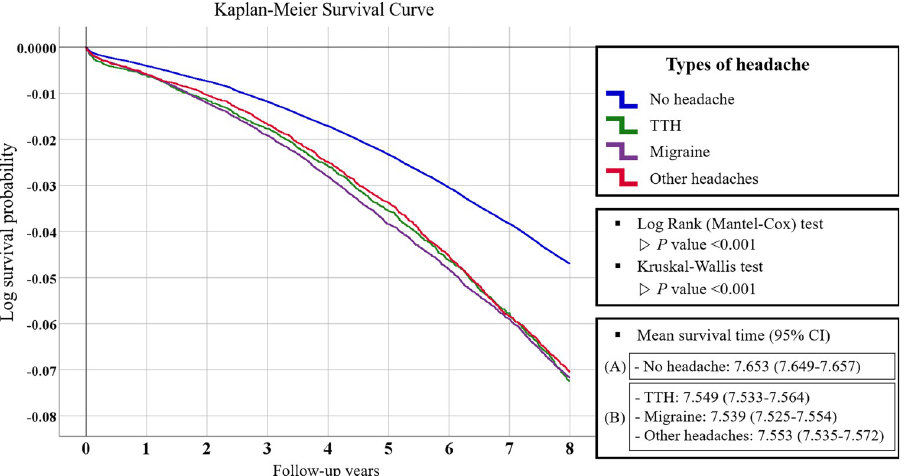
Fig 2. Kaplan–Meier survival curve for log survival probability of all-cause dementias according to headache type over 8 years follow up. Analysis of variance and Bonferroni’s post hoc analysis were performed to compare the difference in mean survival time between the a no headache group and the b headache group. X-axis = follow-up years, Y-axis = log survival probability. TTH = tension type